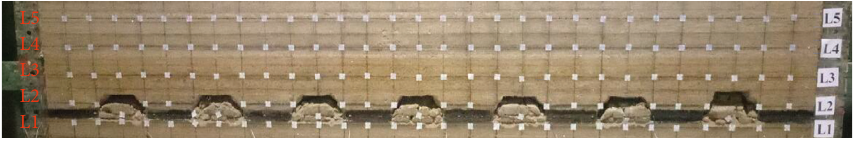
Figure 7: Position of L1–L5.